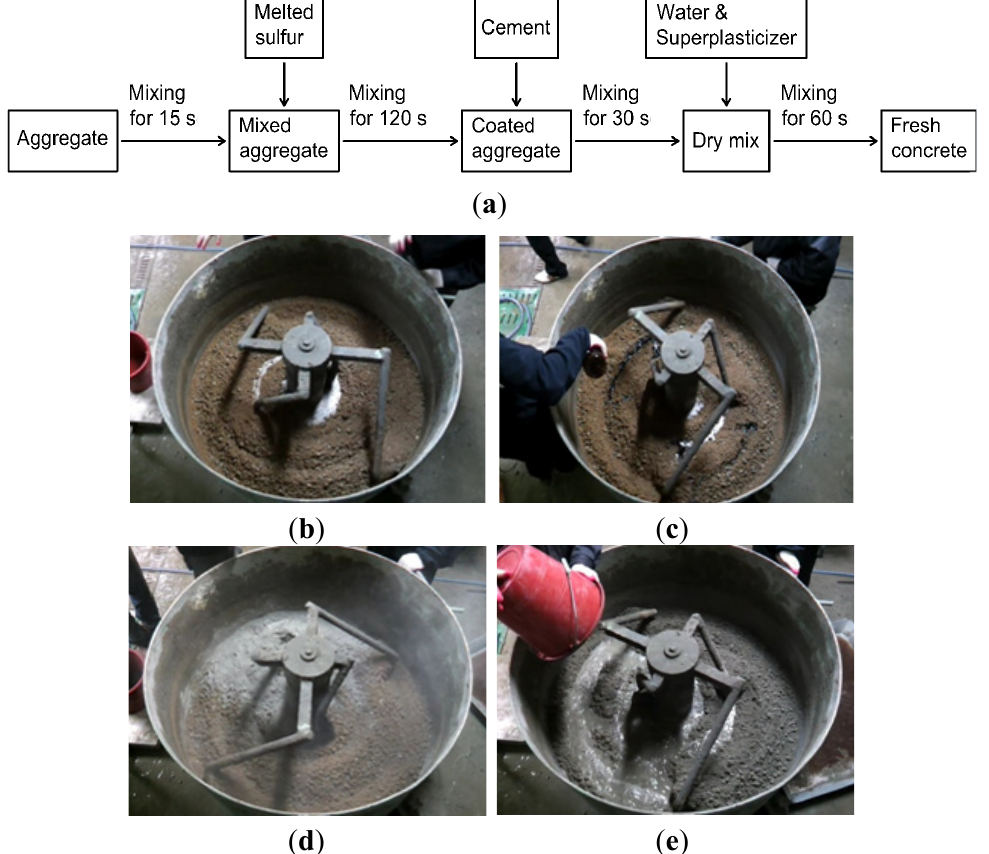
Figure 10. Concrete mixing method: ( a ) mixing procedures; ( b ) mixing of aggregate; ( c ) addition of modified sulfur; ( d ) dry mix; and ( e ) addition of water and